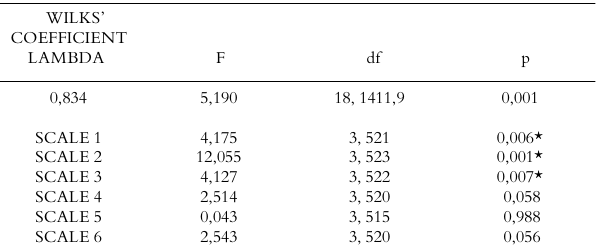
TABLE 9 MANOVA ANDASSOCIATEDANOVAS: COMPARISONOF THE MEANSOF